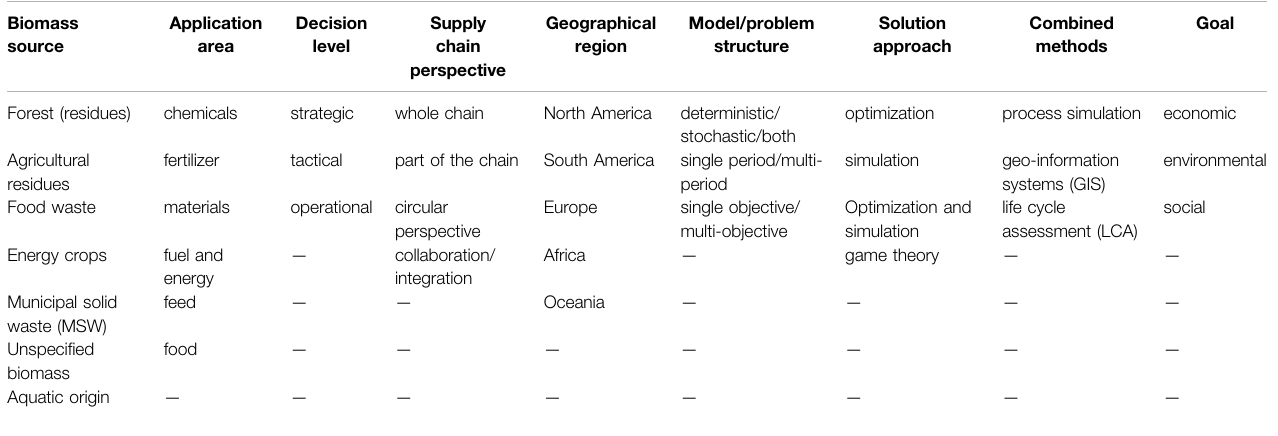
TABLE 3 | Categories used to score the articles in the database. Biomass